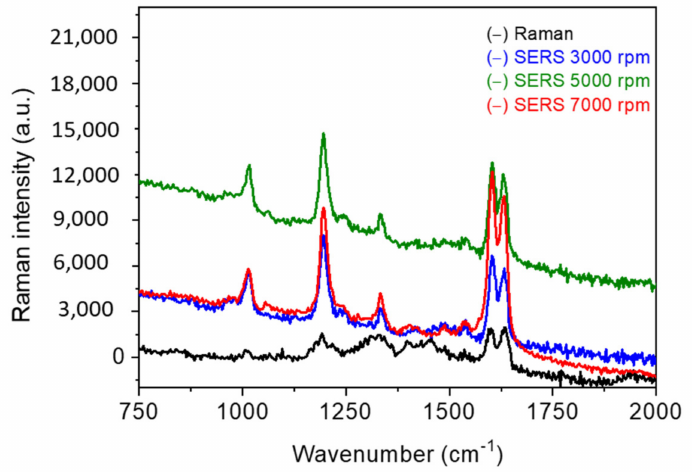
Figure 10. The Raman and SERS spectra of BPE at 10 − 5 M. Raman measurements were obtained with 10 − 2 M of BPE. Spectra were obtained at P = 5 mW over 5 s. Each curve is an average of 10 spectra collected from different positions on the substrate. All spectra were shifted vertically for the observation in all